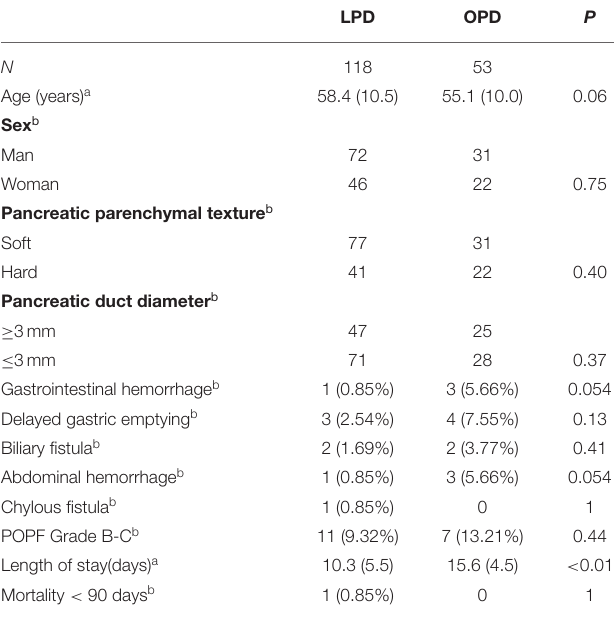
TABLE 2 | Results of the study between laparoscopic pancreatic oduodenectomy (in laparoscopic group 2 patients converted were excluded) and open